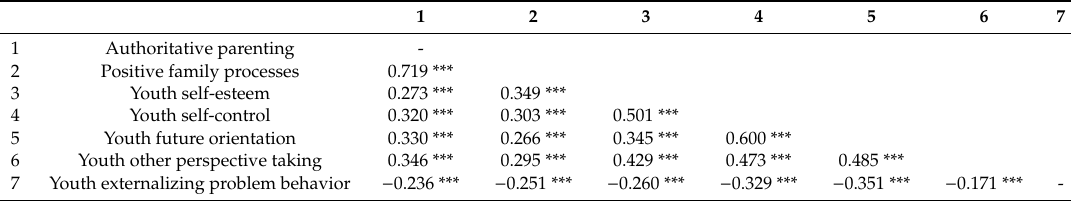
Table 1. Correlations of the study